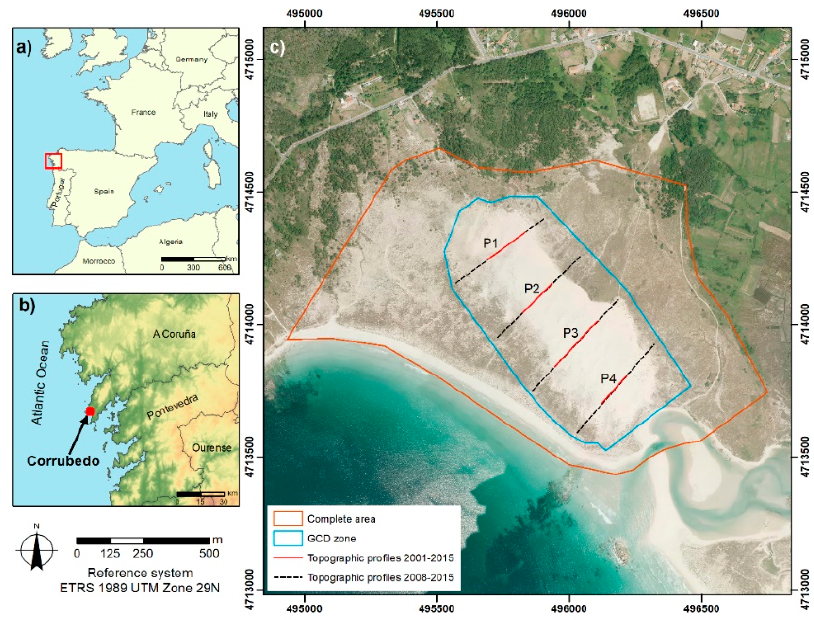
Figure 1. Location map of Natural Park of Corrubedo. 9 ( a ) represent the area in European context; ( b ) shows Corrubedo in west Galicia area; and ( c ) shows the large dune and the analysis zona in detail with the polygons used for analyzing the elevation differences (Geomorphic Change Detection (GCD) zone); the area to analyzed the pathways (Complete area) and the topographic profiles position above PNOA 2017 orthophotography [37].